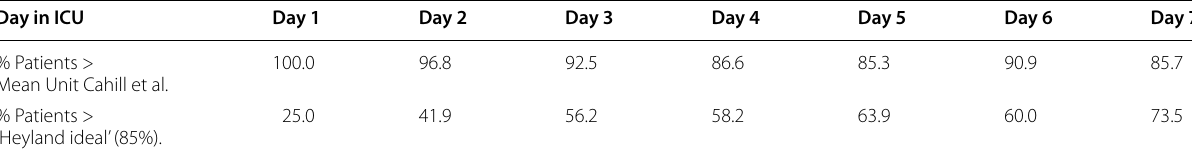
Table 3 Percentage of patients above the Mean ICU reviewed by Cahill et al. [59] and ‘Heyland ideal’ rate of 85% [51] Day in ICU % Patients > Mean Unit Cahill et al. % Patients > ‘Heyland ideal’